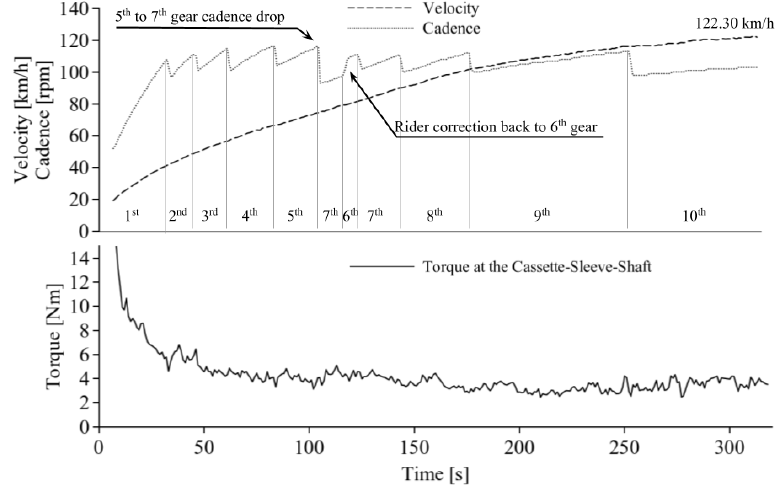
Figure 5. Velocity, cadence and cassette torque from 2017 race data